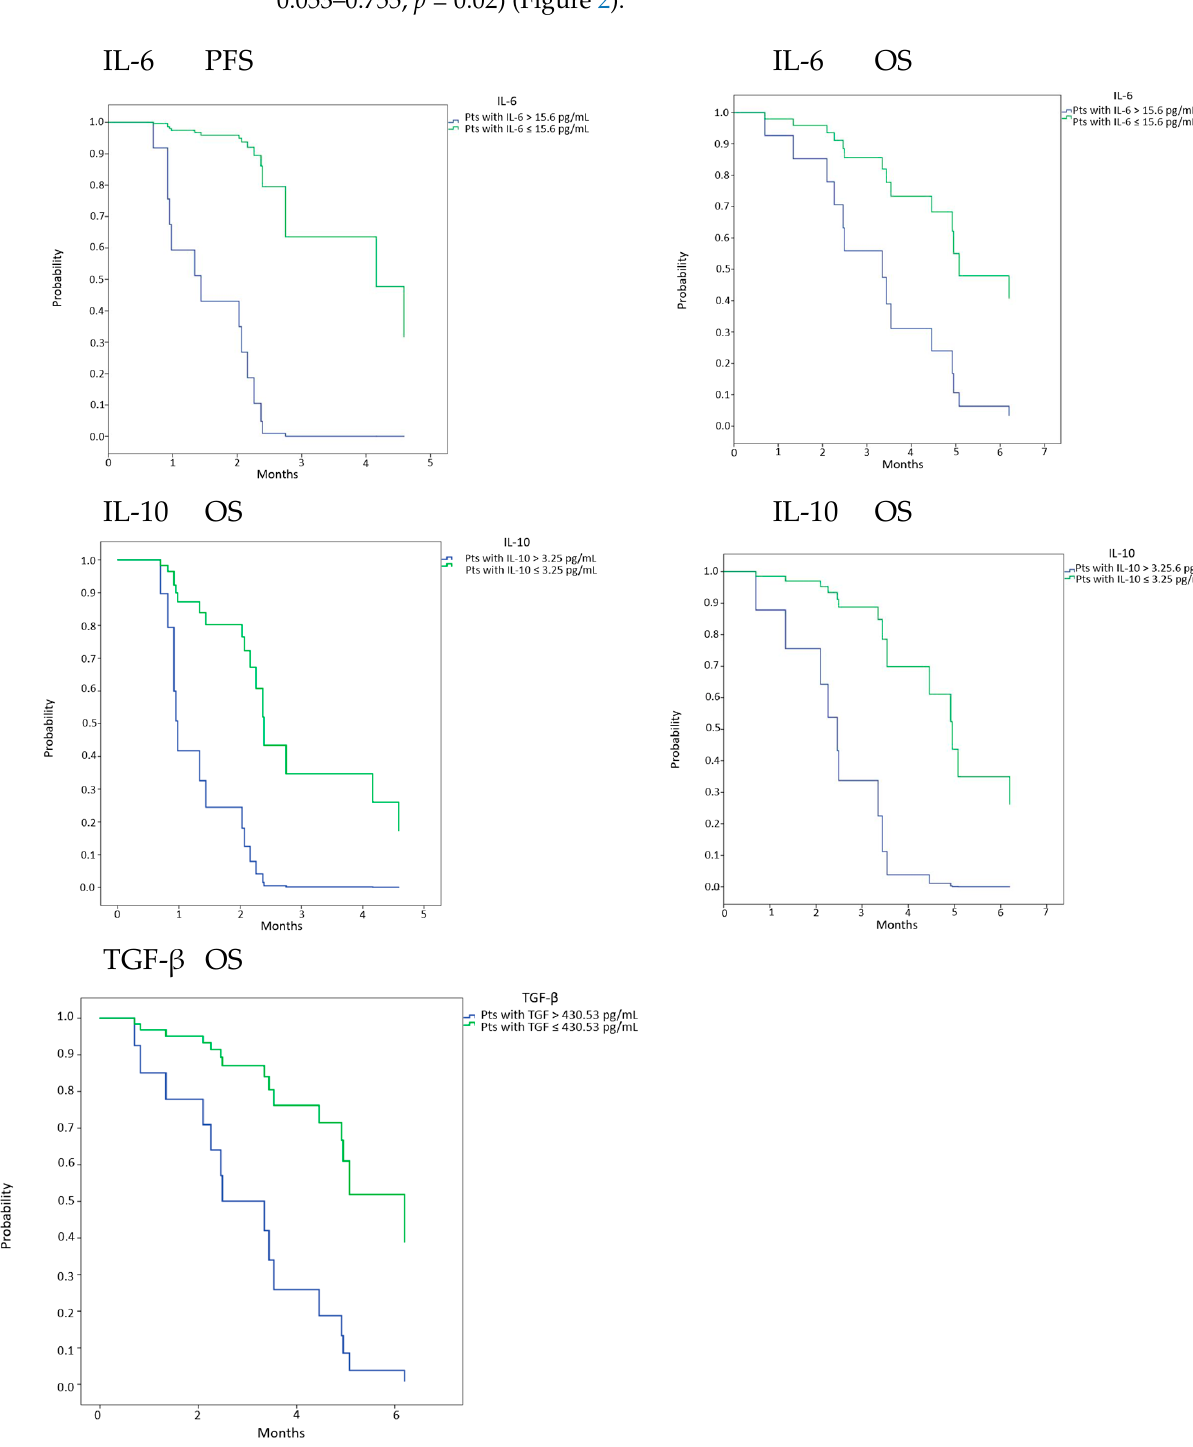
Figure 2. PFS and OS in pts with baseline cytokines levels lower or higher than cut-off point. Cut-off points for each cytokine were calculated using ROC analysis. OS and PFS were expressed in